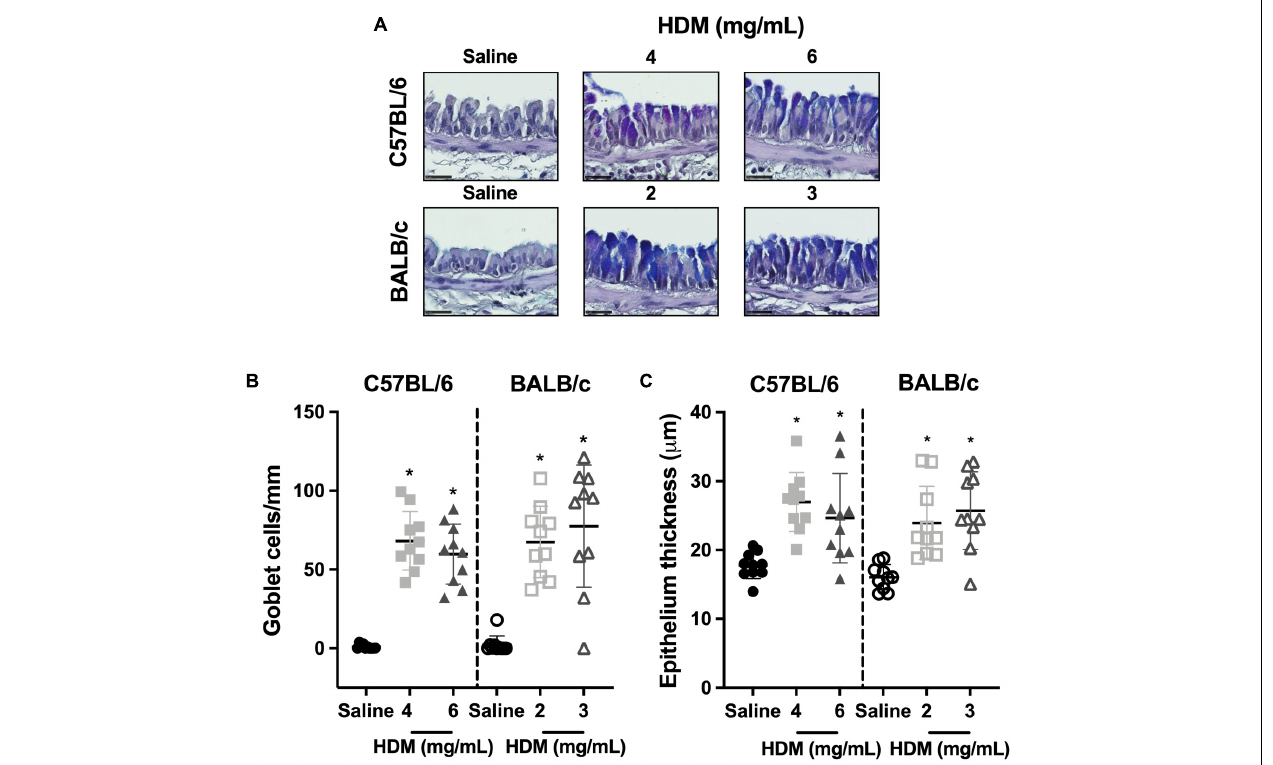
FIGURE 7 | Goblet cell counts and epithelium thickness. The images in (A) show representative lung sections from C57BL/6 (upper panels) and BALB/c (lower panels) mice exposed to incremental doses of house dust mite (HDM) (from left to right). The scale bar is 25 µ m. For each of these images, the number of goblet cells/basement membrane perimeter and the area occupied by the epithelium/basement membrane perimeter were calculated and average results for each mouse in all groups are presented in scatter plots shown in (B,C) , respectively. *Designates significantly different from saline-treated mice within the same mouse strain ( P < 0.05). Data are shown as means ± SD. n = 10 mice per group.